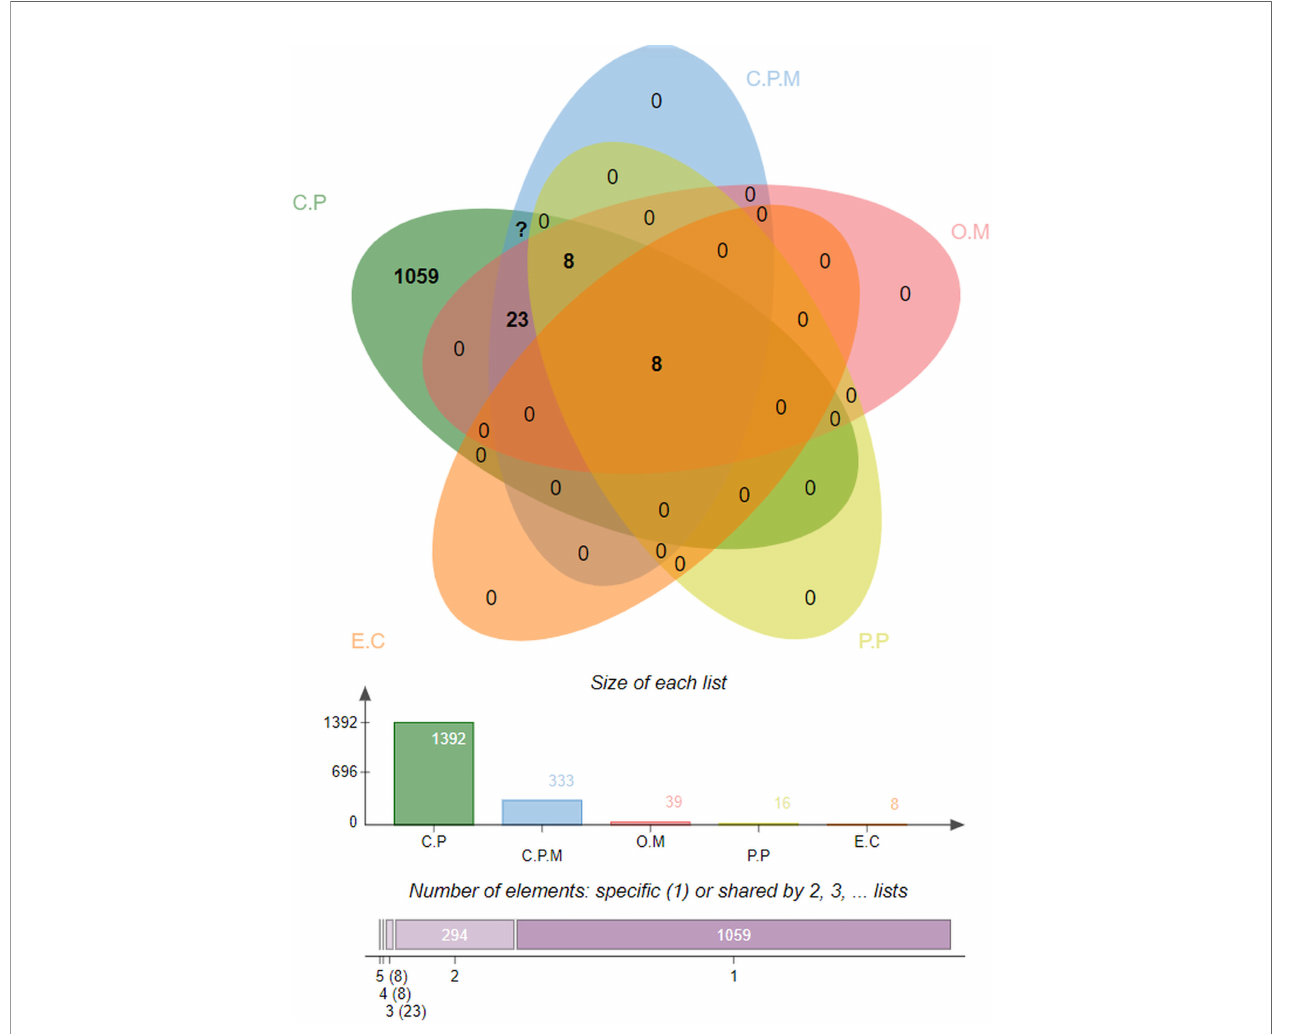
FIGURE 2 | Percent-wise distribution of proteins within the cell, where C.P denotes Cytoplasmic, C.P.M is for Cytoplasmic-membrane, O.M represents Outer- membrane, P.P used for Periplasmic, and E.C is for